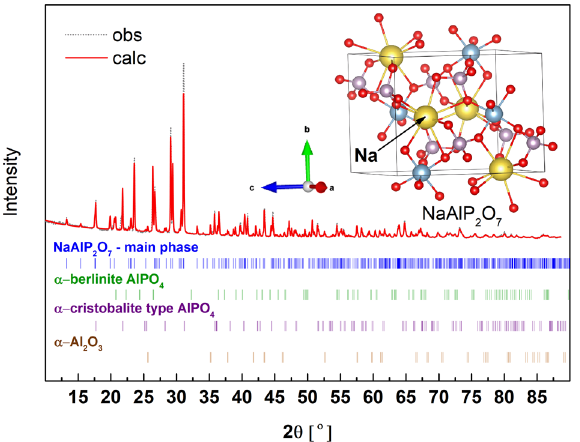
Figure 12. X-ray diffraction pattern (obs) and fit (calc) of NaAlP 2 O 7 . Inset, the unit cell of the compound with the optimized atom positions.